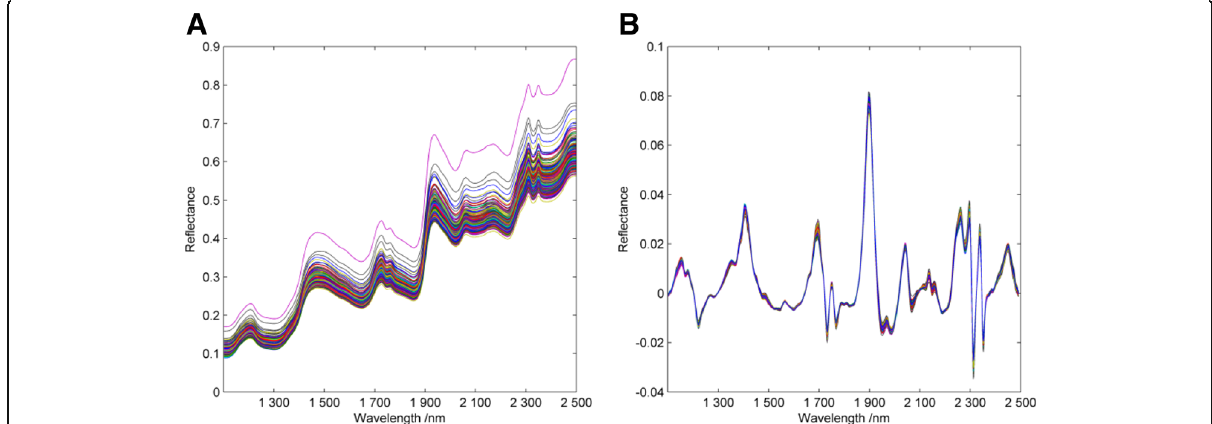
Fig. 1 The NIR spectra of cottonseed meal. a The original spectra. b The spectra after pretreated by SNV combined with first derivatives